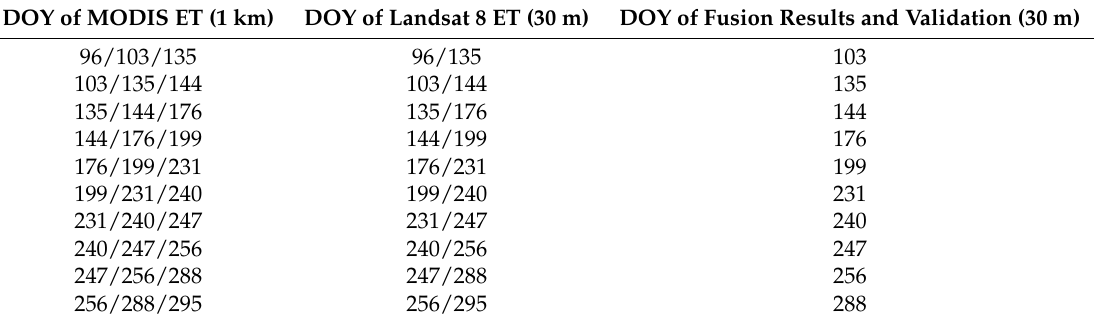
Table 3. Fusion strategy: day of year (DOY) of the input data and results. DOY of MODIS ET (1 km) DOY of Landsat 8 ET (30 m) DOY of Fusion Results and Validation (30